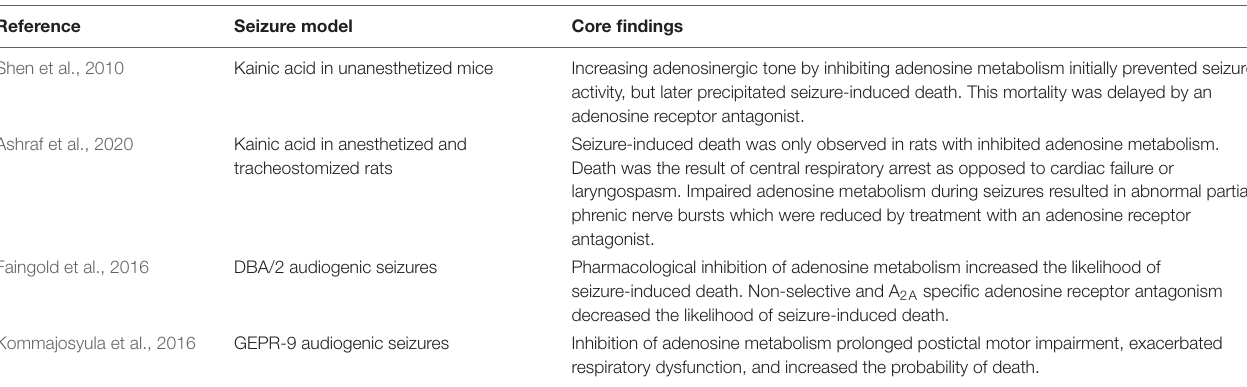
TABLE 3 | Experimental evidence which directly supports the adenosine hypothesis of SUDEP. The Deadly: Seizure-induced increases in extracellular adenosine may precipitate SUDEP by excessive inhibition of brain areas that are necessary for